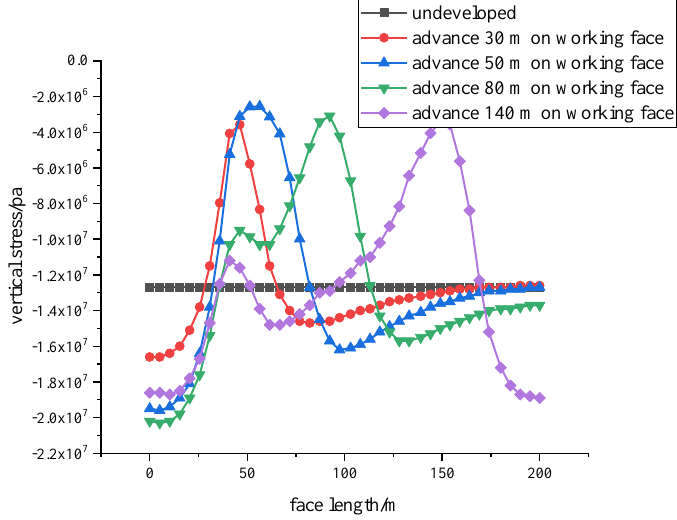
Figure 10. Vertical stress diagram of working face advancement at different distances.